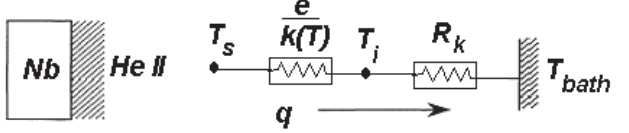
FIG. 1. Thermal circuit of a defect-free SRF cavity in a pool of helium at bath temperature of T bath . T s is the rf surface tempera- ture of Nb cavity with thickness e and having temperature dependent thermal conductivity k ð T Þ . T i is the intermediate temperature representing outer surface temperature and R k is the Kapitza resistance when the helium is in the superfluid phase.